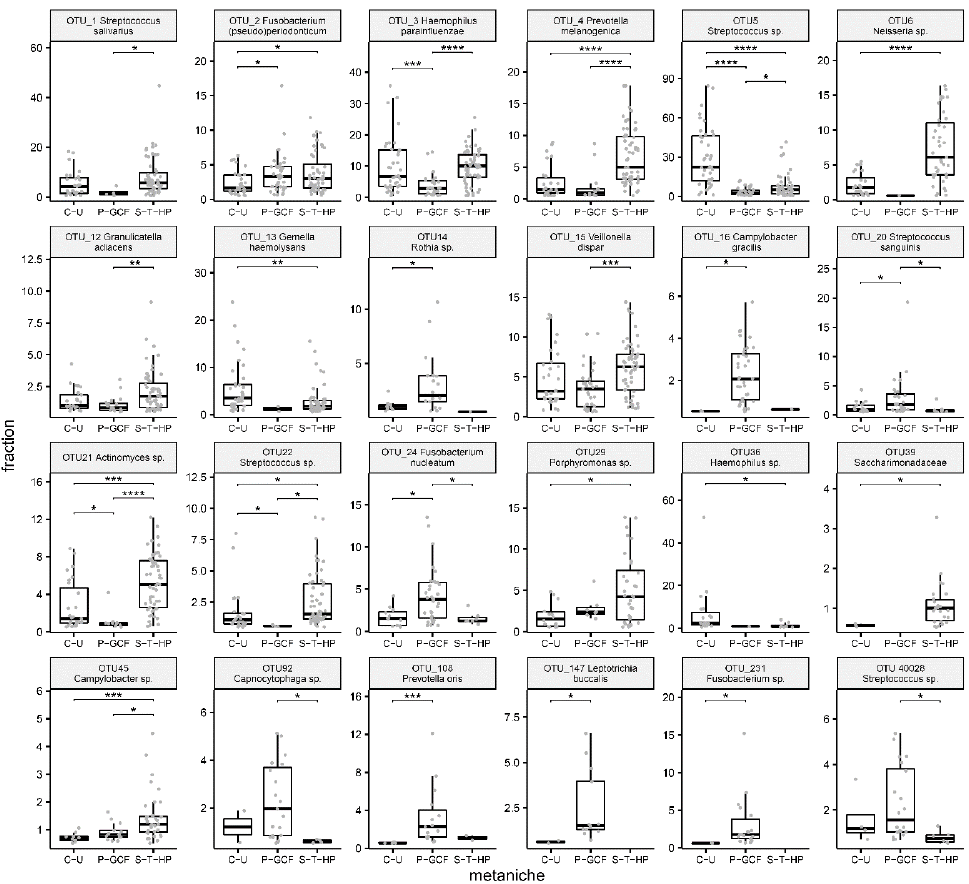
Figure 3. Characteristic operational taxonomic units (OTUs) for three different defined metaniches “plaque and gingival crevicular fluid” (P-GCF), “saliva, tongue and hard palate” (S-T-HP) and “cheek-sublingual” (C-U) are shown. The data is presented as median, 25 and 75 percentiles (box) and 1.5 × interquartile range of the 25 and 75 percentiles (whiskers). Raw data ( n = 0-59) is displayed as overlaying grey points. Statistical analysis was performed using Mann-Whitney U-tests and was adjusted for sample size using the Benjamin–Hochberg algorithm. * 0.01 ≤ p < 0.05, ** 0.001 ≤ p < 0.01, *** 0.0001 ≤ p < 0.001, **** p < 0.0001.